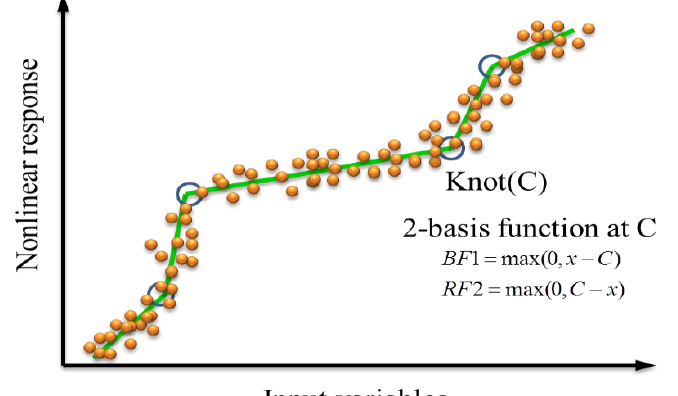
Figure 4. Structure for MARS model.